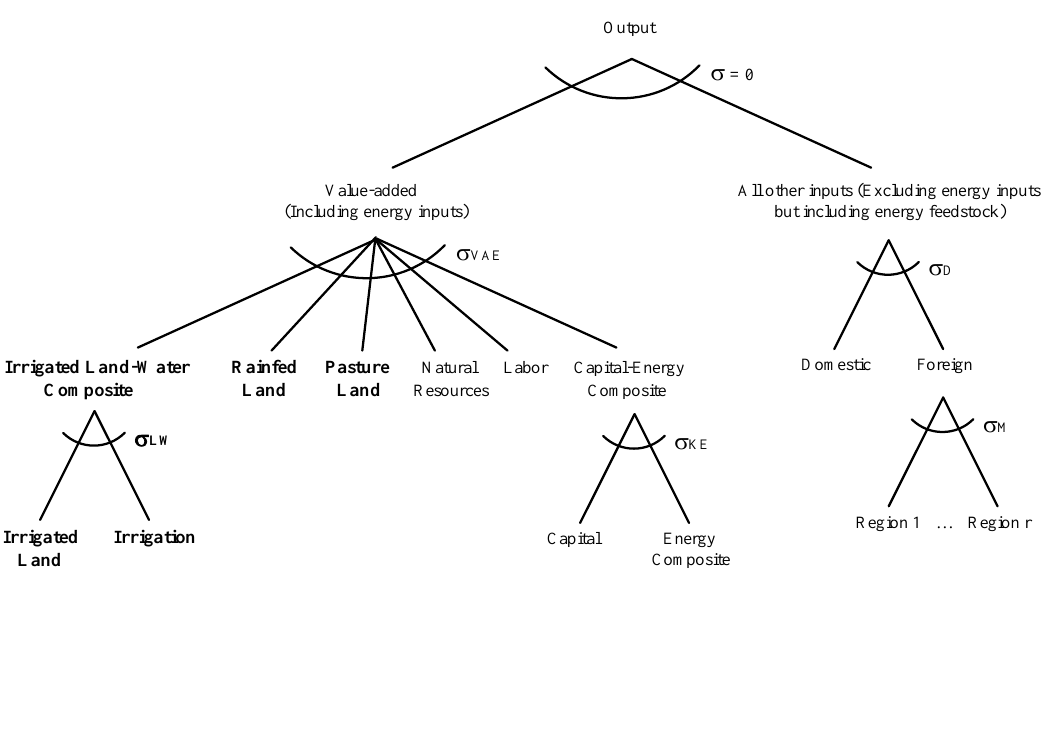
Figure A1 . Nested tree structure for industrial production process in GTAP-W